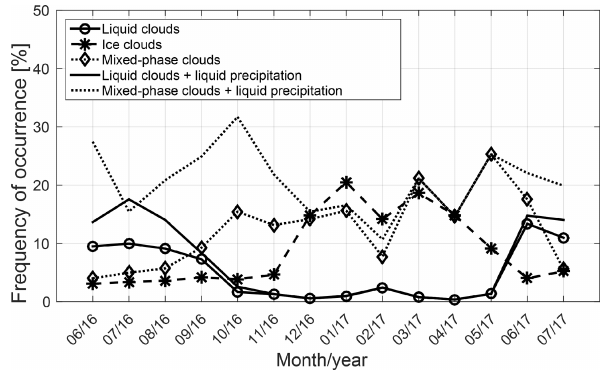
Figure 10. Frequency of occurrence of ice-only, liquid-only, and mixed-phase single-layer clouds based on Cloudnet categorization data (for lines with circles, diamond and star profiles with liquid precipitation are not included). The frequency is given in % and normalized to the total number of Cloudnet profiles in each month.